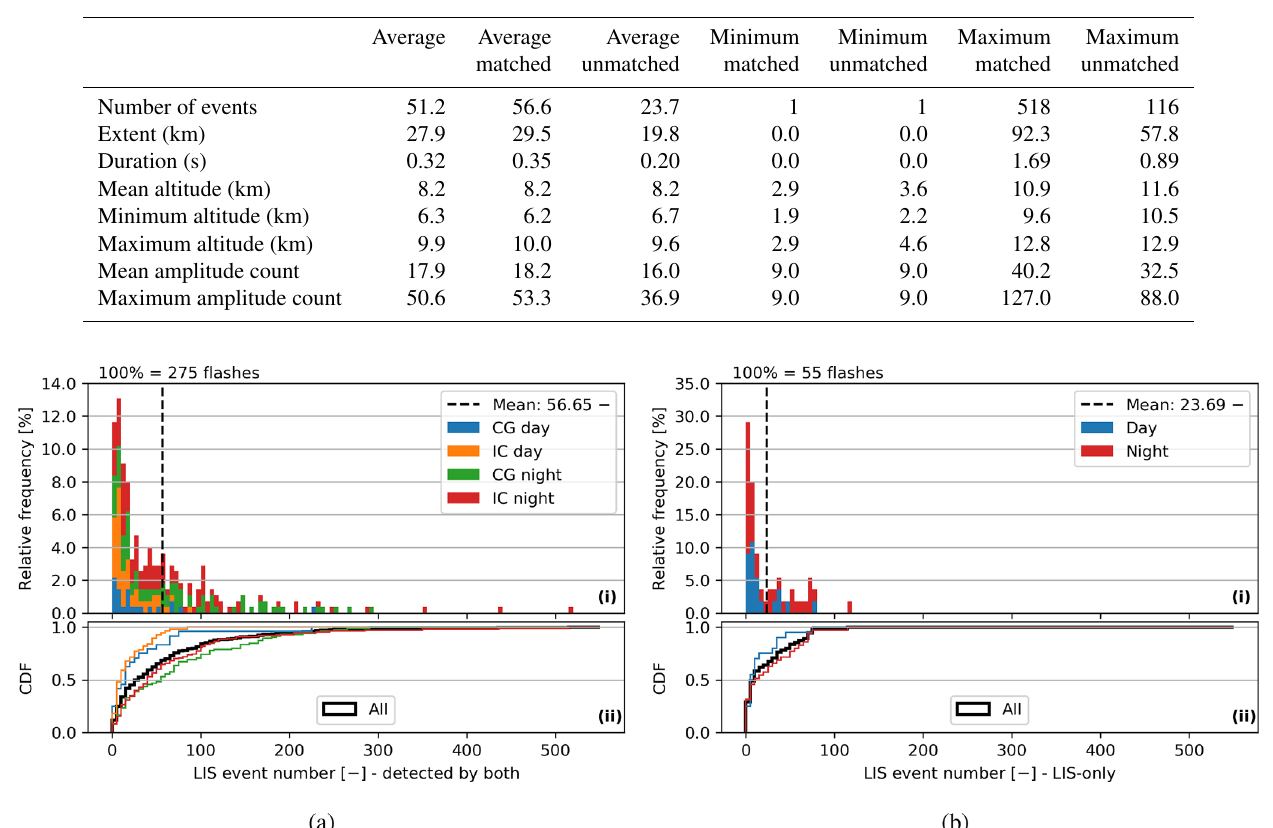
Figure 7. LIS event numbers of ISS-LIS flashes with a coincident Meteorage flash (a) and unmatched ISS-LIS flashes (b) . Daytime, nighttime and flash type, IC and CG, are indicated by the colors. The histogram (i) and corresponding CDF (ii) use the same colors. The CDF additionally shows a black curve for all data. The histogram bin width is constant at five events. Note: the CG–IC attribute for an ISS-LIS flash needs the matched Meteorage flash and does not exist for ISS-LIS-only flashes. The mean value is plotted as a dashed line. The total number of flashes is indicated above the